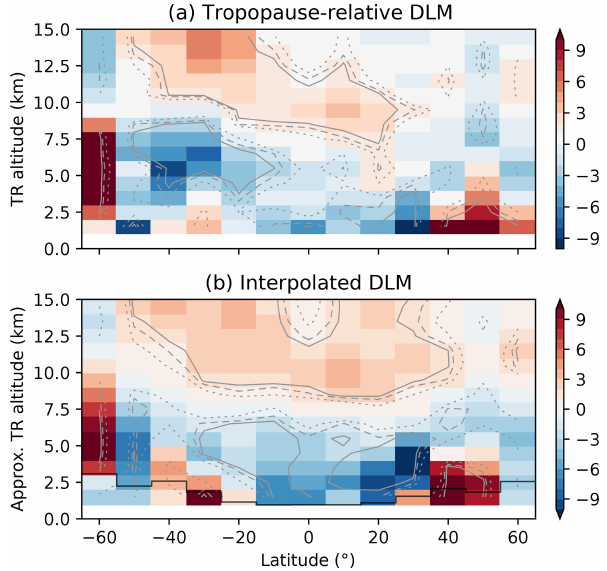
Figure 6. Percent ozone change from 2000 to 2021 using DLM. (a) Trends in tropopause-relative (TR) coordinates. The bottom layer is empty by definition. (b) Results from Fig. 2b are interpo- lated to an approximate TR grid using the mean altitude of the first tropopause. The black line indicates the plotting limits in the origi- nal figure. Significance contours as shown in Fig.